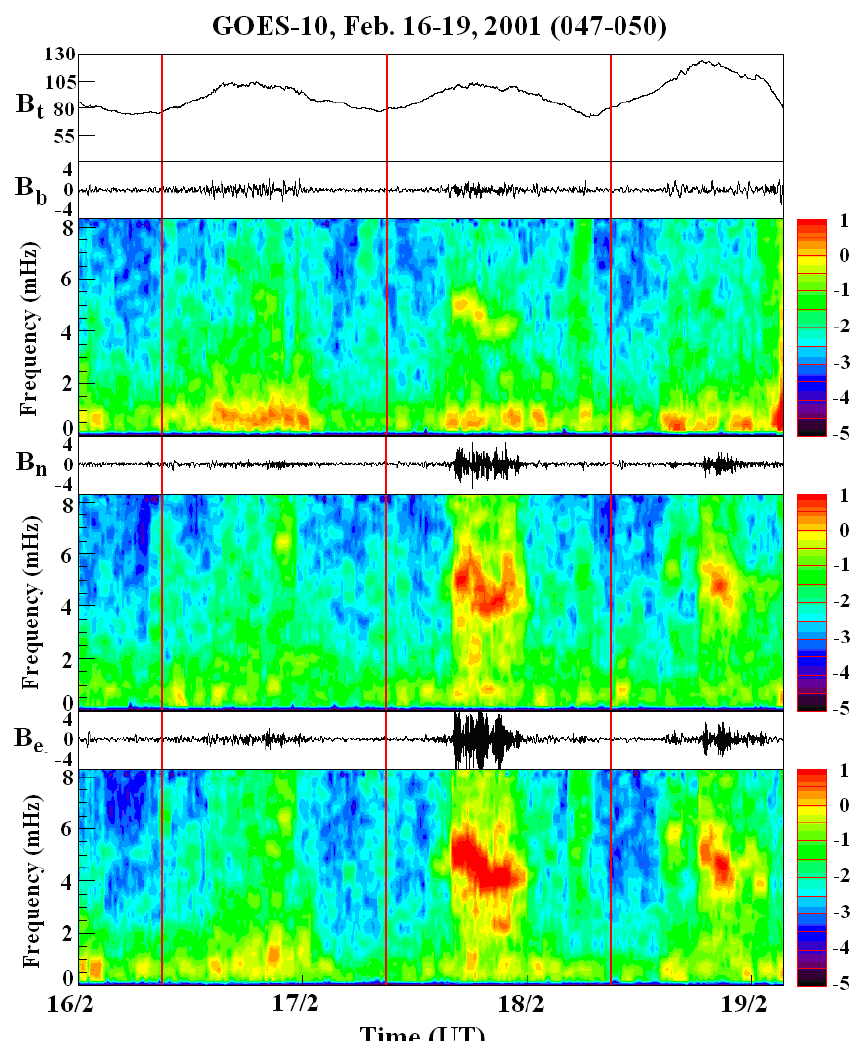
Fig. 1b. The magnetic field of the pulsation measured by GOES-10 from 16 to 18 February 2001 is plotted in the Mean Field-Aligned coordinate system, similar to Fig. 1a. The red lines correspond to the time when GOES-10 crosses local midnight, which is at 09:00 UT every